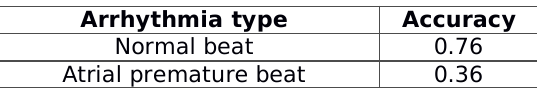
Table 2. The accuracy of each